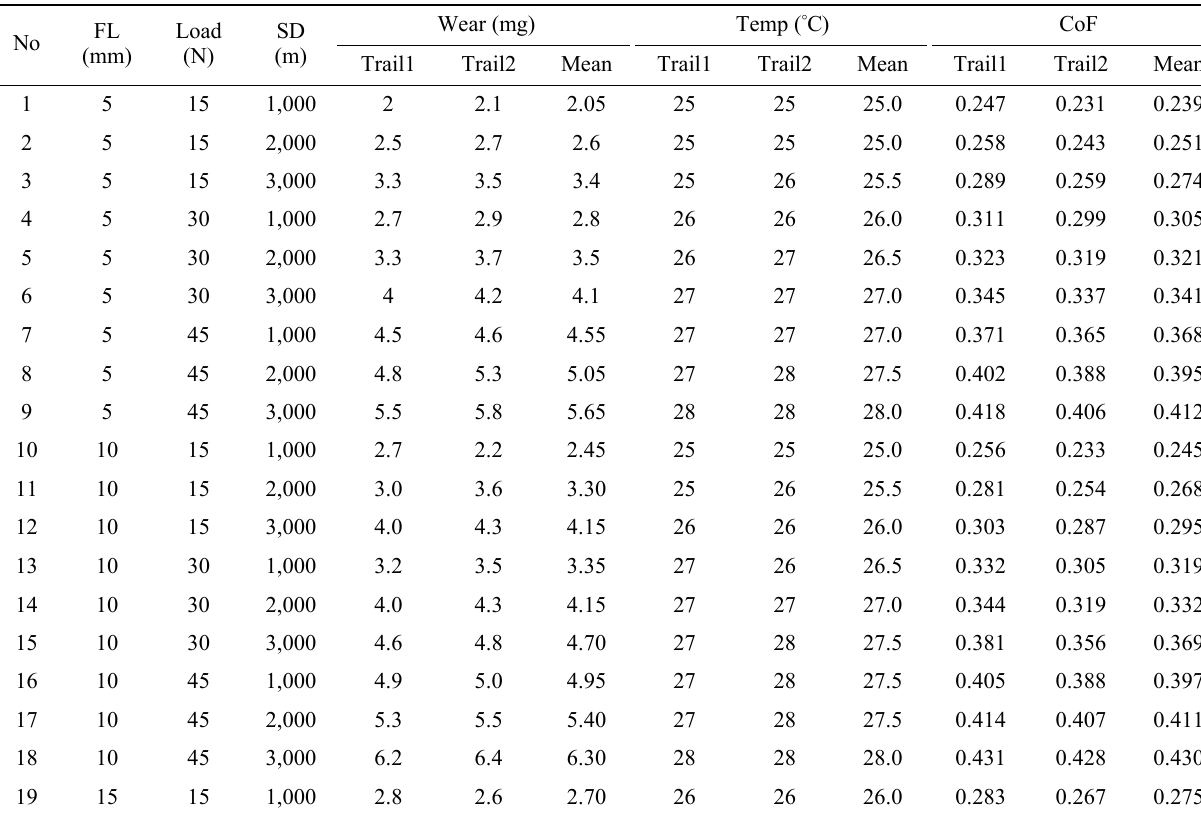
Table 6 Full factorial design of